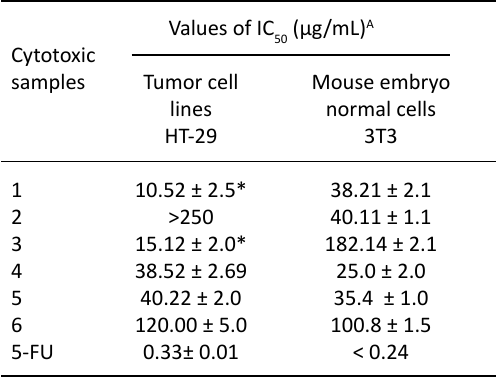
Table 2. Cytotoxicity of ethanolic extract and fractions of Dodonaea viscosa on human tumor cell